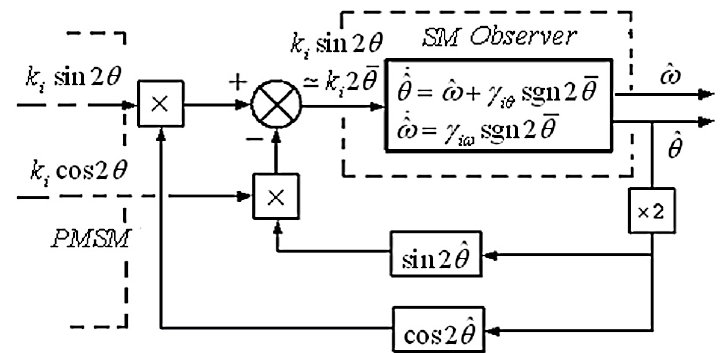
Figure 4. An equivalent block diagram for PMSM speed and position estimation based on sliding mode observer (SMO).